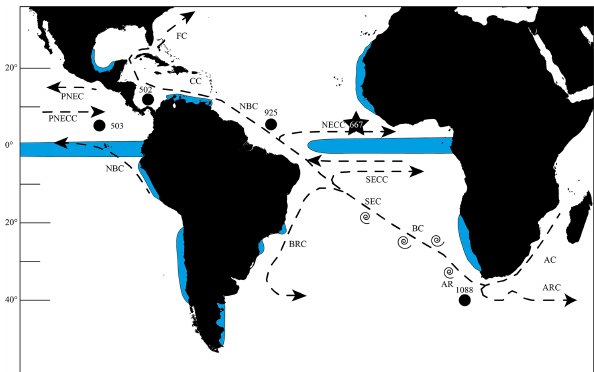
Figure 1. Map of the southern and tropical Atlantic Ocean show- ing the investigated and other important sites, as well as the most important currents. The star marks Site 667 and the black dots Sites 502, 503 and 925, which were investigated by Knapperts- busch (2007a, 2016), as well as ODP Site 1088, which was used by Dausmann et al. (2017) for a reconstruction of the AMOC strength using ε Nd isotopes. Blue areas show regions of upwelling (Shipboard Scientific Party, 1998, 2003; Merino and Monreal- Gómez, 2009; Clyde-Brockway, 2014; Pelegrí and Benazzouz, 2015; Kämpf and Chapman, 2016). Currents following Shipboard Scientific Party (1998). AC = Agulhas Current, AR = Agulhas Rings, ARC = Agulhas Return Current, BC = Benguela Current, BRC = Brazil Current, CC = Caribbean Current, FC = Florida Current, NBC = North Brazil Current, NECC = North Equato- rial Counter Current, PNEC = Pacific North Equatorial Current, PNECC = Pacific North Equatorial Counter Current, SEC = South Equatorial Current, SECC = South Equatorial Counter